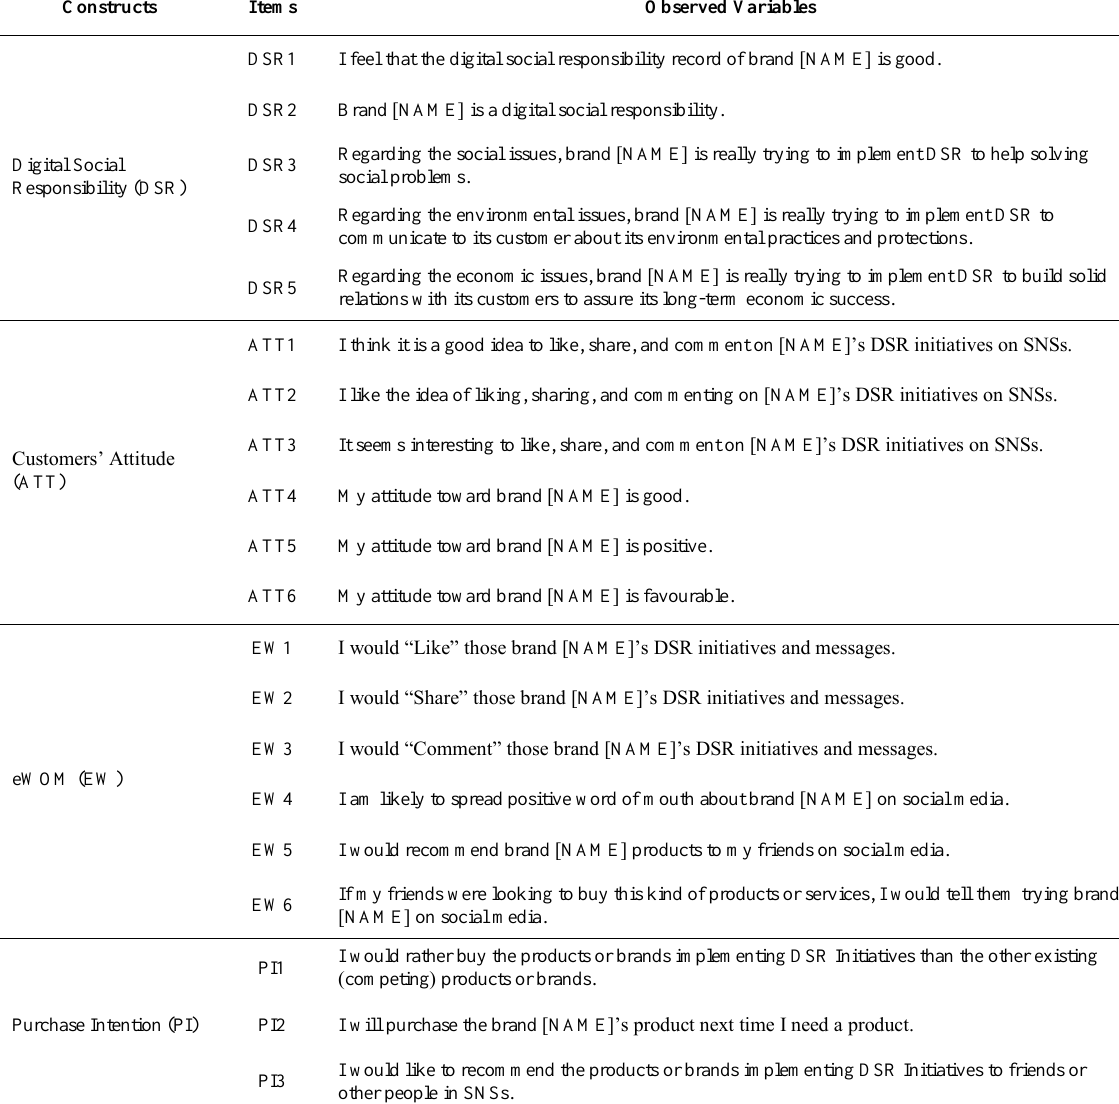
Table 1. Details of the questionnaire constructs and